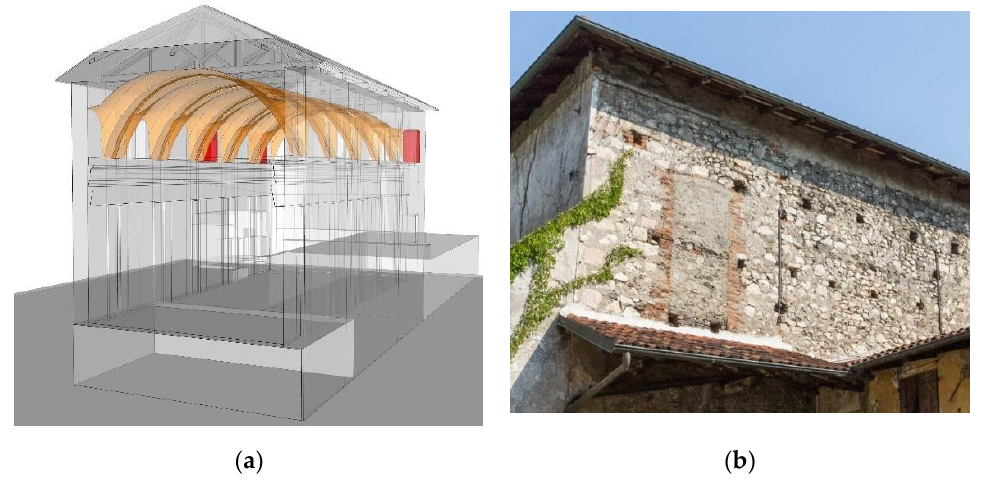
Figure 9. ( a ) Drawing of the church of St. Marta after the masonry vault has been added and with the windows paneled highlighted in red and ( b ) one of the paneled windows.